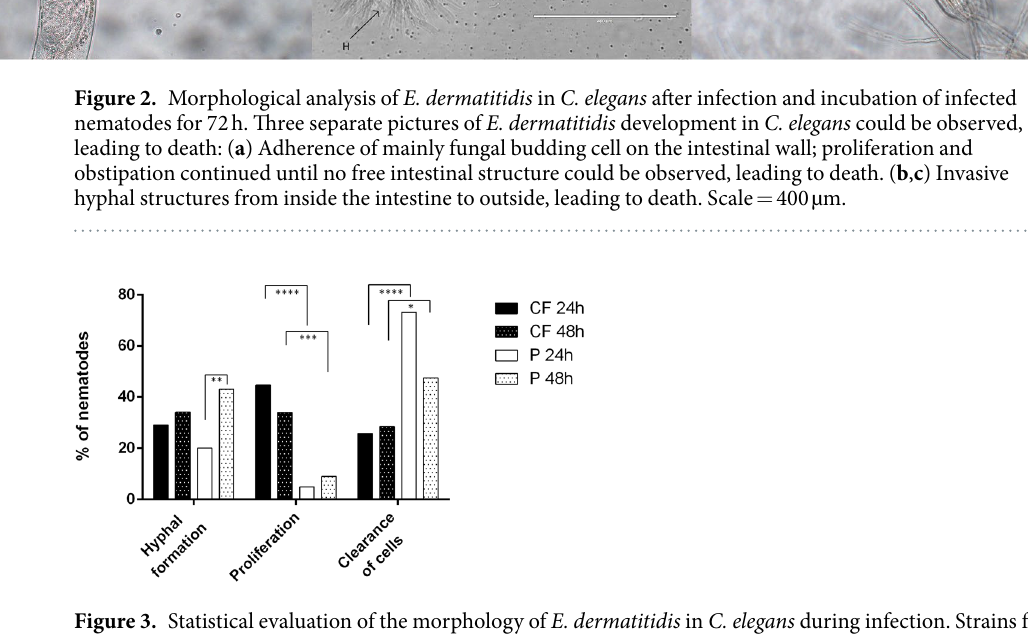
Figure 3. Statistical evaluation of the morphology of E. dermatitidis in C. elegans during infection. Strains from cystic fibrosis patients (CF) strains exhibited no significant differences in morphological development after infection for 24 h or 48 h. Strains from Asian patients (P) exhibited significantly more hyphal formation after infection for 48 h than after infection for 24 h. Rates of nematodes were calculated with Kaplan-Meier statistics; comparison were performed with Mantel-Cox log-rank tests with statistical significance set at the level of P ≤ 0.05. * P ≤ 0.05; ** P ≤ 0.01; *** P ≤ 0.001; **** P ≤ 0.0001, n =